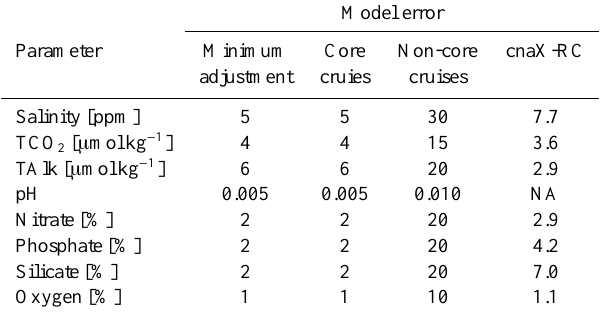
Table 2. Table listing: (2nd column) the minimum adjustment applied to the data product; (3rd and 4th columns) the maximum model error in the Weighted Damped Least Square (WDLSQ) in- versions for core cruises and non-core cruises; (5th column) the RMSE of the di ff erence in o ff sets calculated by the running-cluster and the cnaX